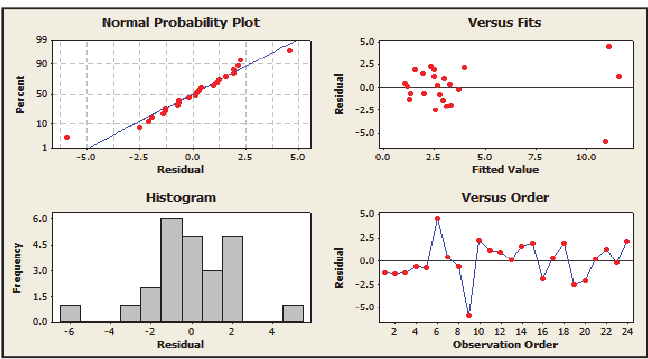
Fig. 13. Residual plots for Blow holes